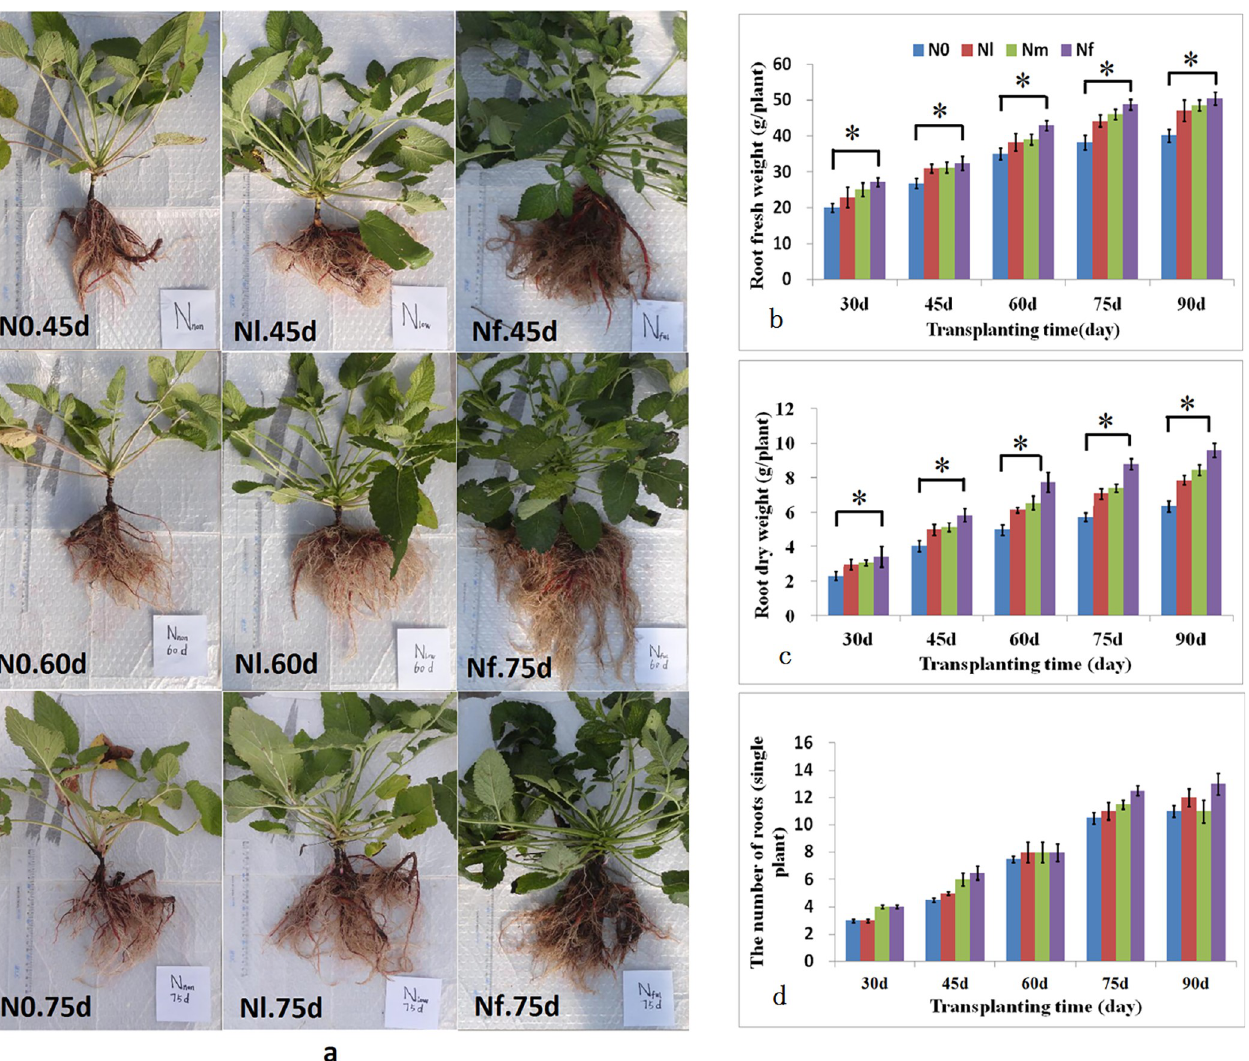
Fig 2. The effects of low nitrogen level on the growth in S . miltiorrhiza roots at 45, 60, 75, and 90 days after transplanting (DAT). (a) Phenotypes of S . miltiorrhiza under Full-N (Nf) and N-deficient conditions (Non-N(N0) and Low-N (Nl)) at the indicated times (Photographed by Li-Lan Lu). (b) Fresh weight of the roots under full-nitrogen (Nf), middle level-nitrogen (Nm), low-nitrogen (Nl), and non-N (N0) conditions at the indicated times. (c) Dry weight of the roots, (d) number of the roots. Values are presented as means ± SD, n = 5. Asterisks ( � ) indicate significant differences (P < 0.05, Student’s t